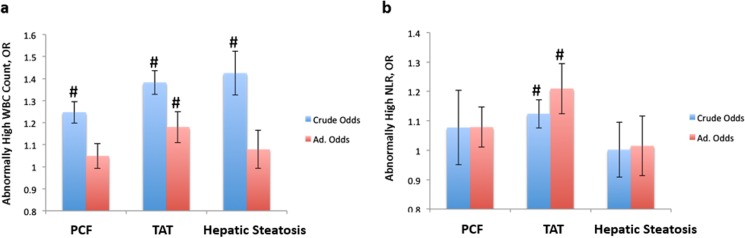
Odds of abnormally high WBC (a) and NLR (b) in relation to increasing PCF, TAT, and presence of hepatic steatosis. The crude and adjusted (adj.) odds ratios (OR) for PCF, TAT and Hepatic Steatosis in identifying abnormally high total leukocyte counts (WBC, cut-off: >6.9 * 103/μL) and NLR (cut-off: >2.51).